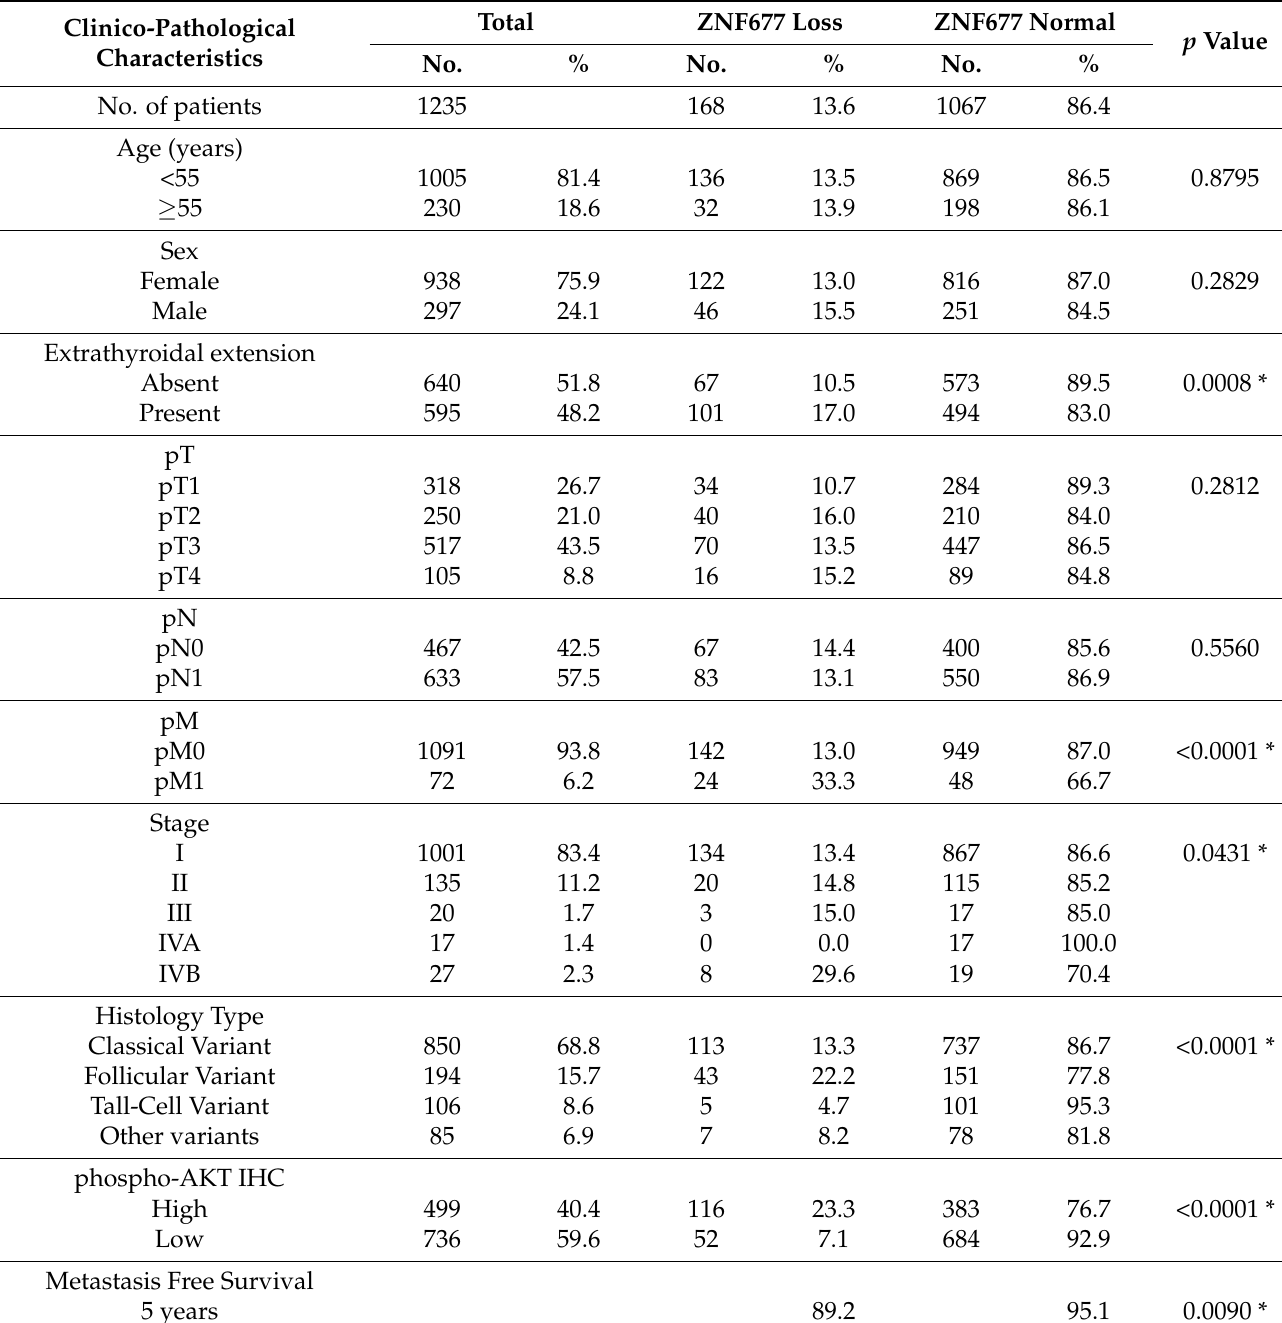
Table 2. Association of clinico-pathological characteristics with ZNF677 expression in PTC.